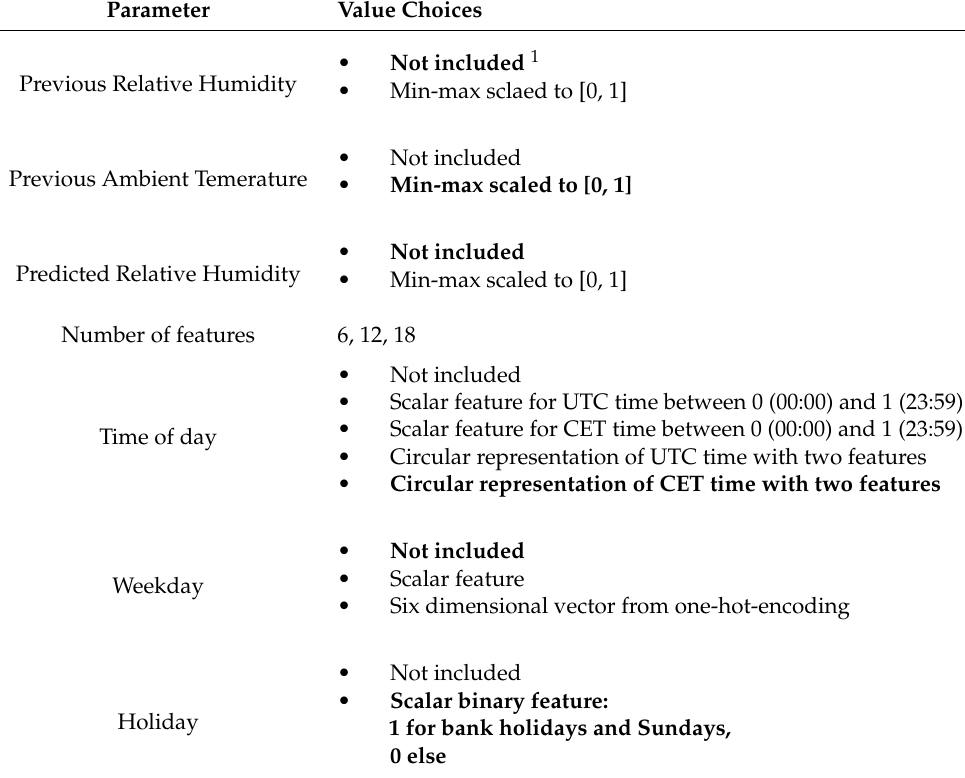
Table A3. Considered parameters and their value choices for feature engineering.